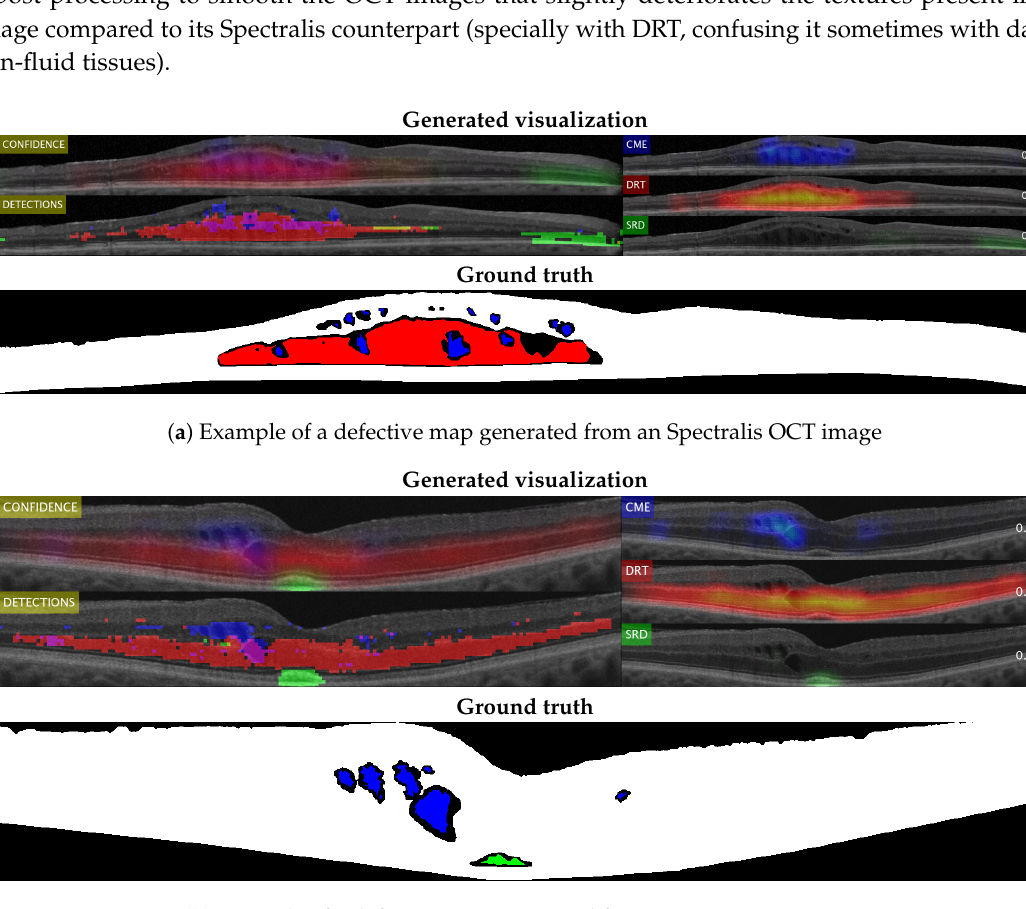
Figure 16. Representative visualizations from both devices with visible